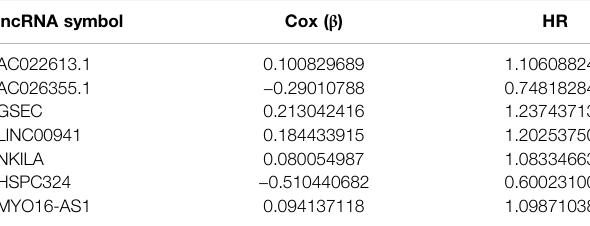
TABLE 2 | Information of seven hypoxia-related lncRNAs associated with OS in patients with LUAD. lncRNA